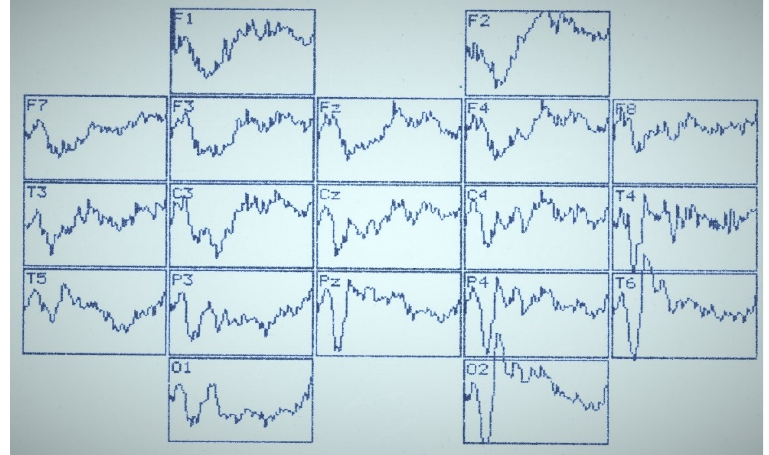
Figure 2. VEP distribution by the 10/20 system with correct recognition of images-illusions. Analysis epoch: 1000 ms.